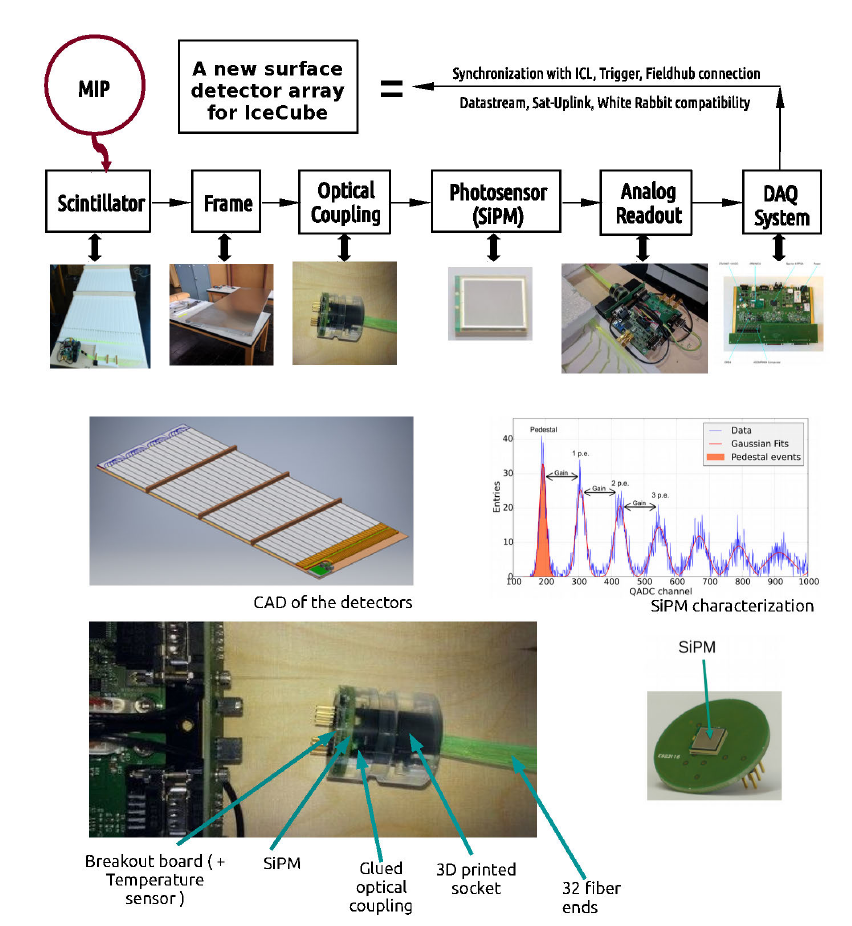
Figure 2. Prototype scintillator detector design, here of the IceTAXI system. Taken from